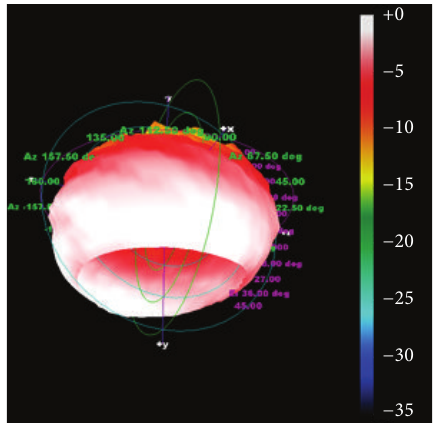
Figure 13: 3D measured radiation pattern at 8GHz.